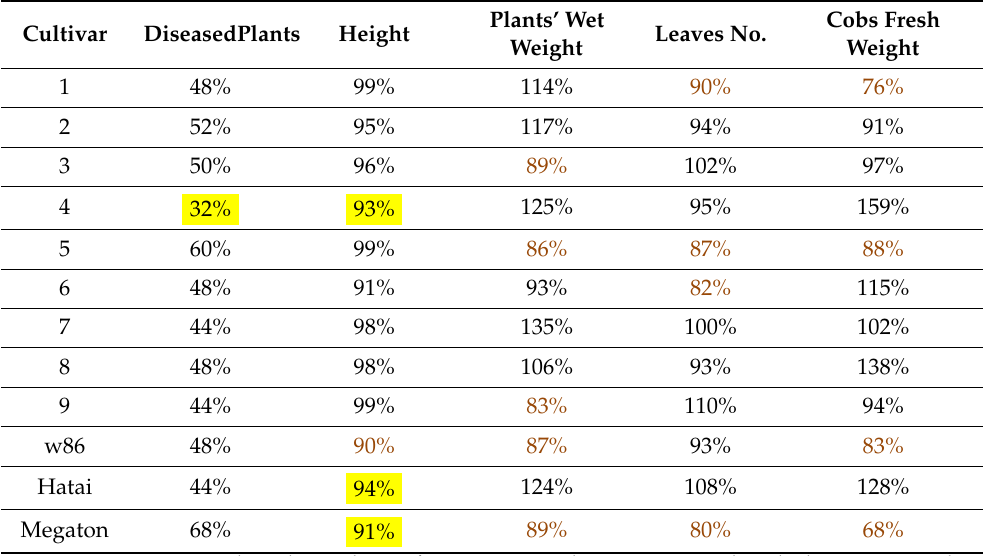
a Disease severity was evaluated according to four categories. The experiment is described in Figure 3. Values indicate the mean of five repeats (pots, each having one plant). Data are the percentages of diseased plants compared to the control treatments (soils without complementary inoculation). Numbers highlighted in yellow are significantly different ( p < 0.05, t -test) from the control. Numbers highlighted in brown are growth values of 90% and